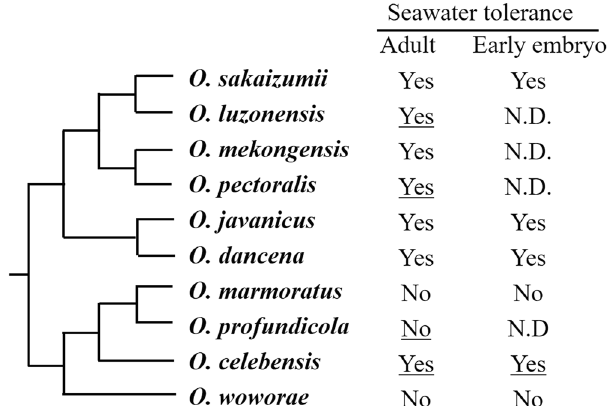
Figure 1. Phylogenetic relationships and seawater adjustability in Oryzias fishes showing that osmotic tolerance has evolved repeatedly. Phylogenetic information was taken from Takehana et al . 26 and Mokodongan and Yamahira 27 . Species examined in the present study are underlined. “Yes” and “No” based on their ability to survive in fresh or sea water, respectively. N.D. indicates no data.